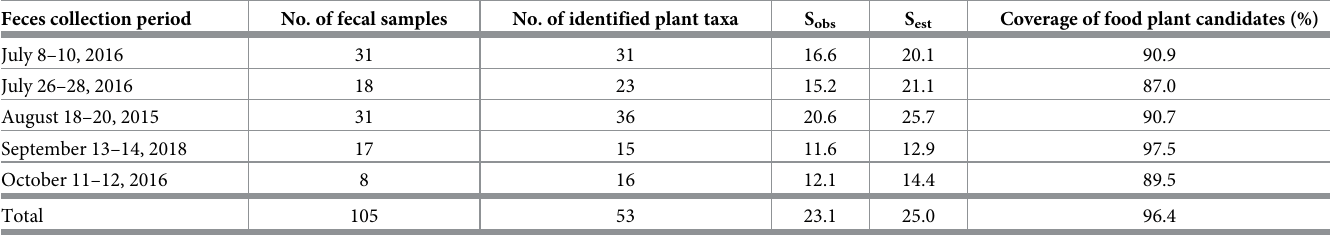
Table 5. Estimated asymptotic Shannon diversity and coverage of food plant candidates for each fecal sampling period. Feces collection